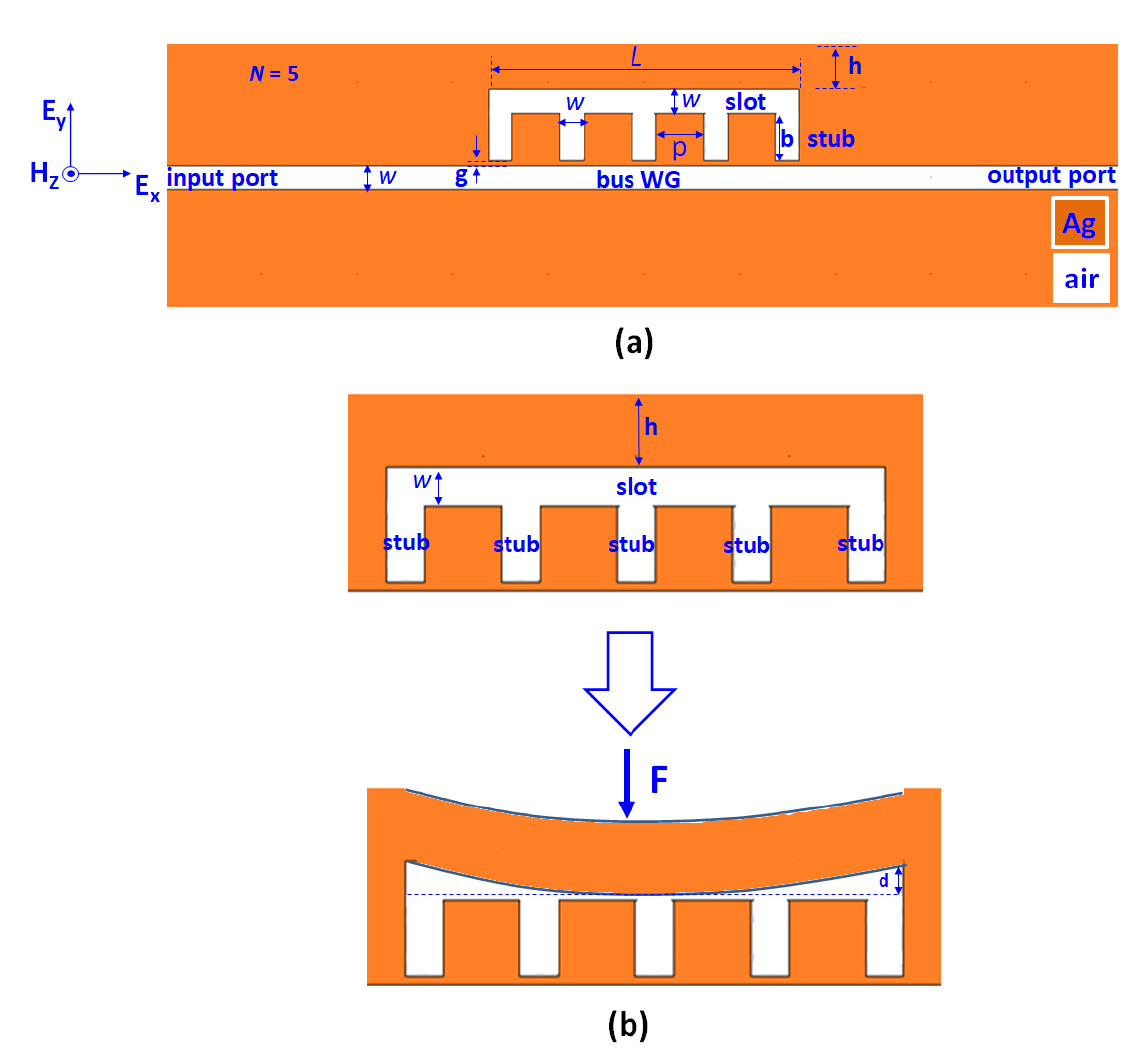
Figure 1. ( a ) Schematic diagram of the designed sensor. ( b ) Schematic diagram of an applied pressure F exerted on the Ag layer.